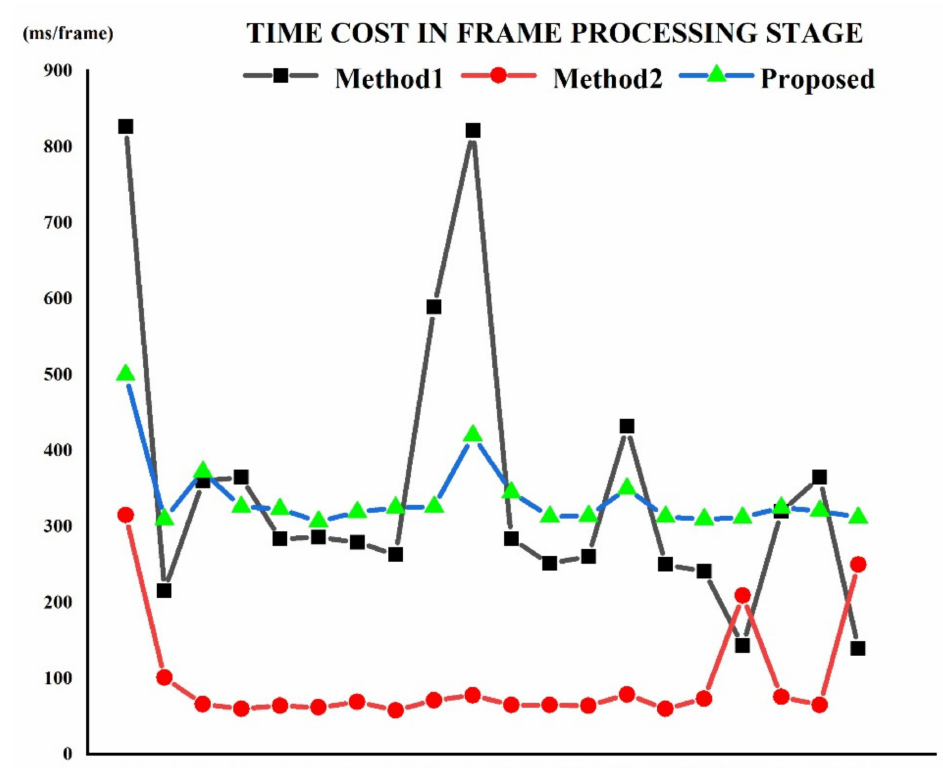
Figure 10. Average time cost in the frame processing